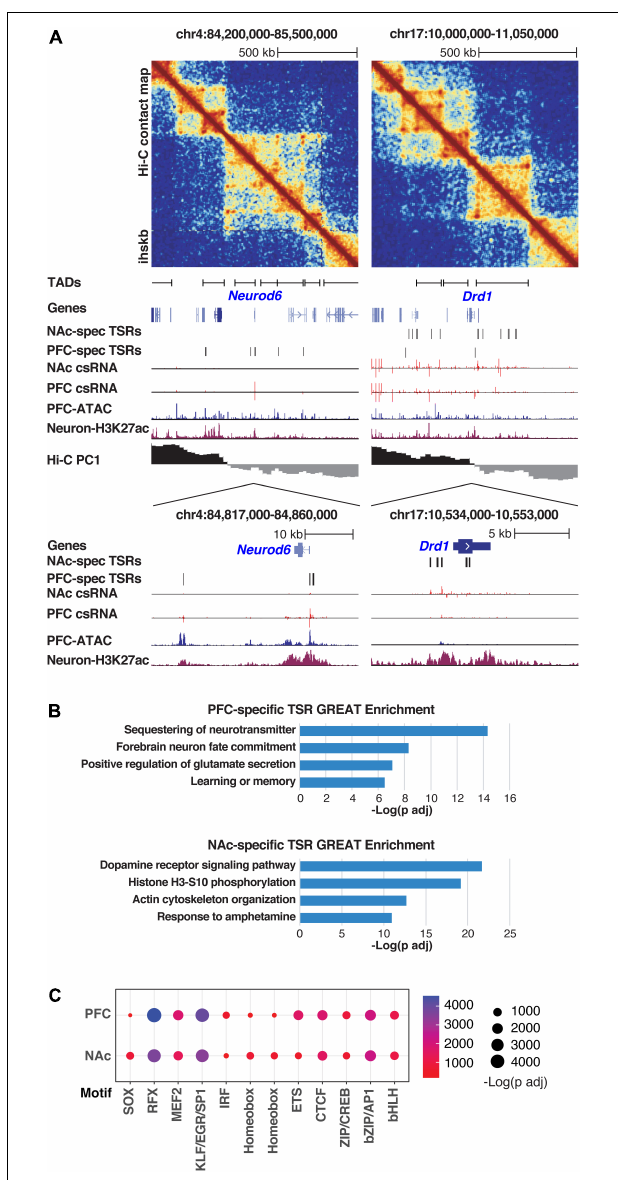
FIGURE 2 | Brain region specificity of Transcriptional Start Site Regions (TSRs). (A) Neurod6 (left) and Drd1 (right) gene loci are visualized, including (top to bottom) Hi-C contact matrix, TAD positions, genome browser tracks showing tissue-specific TSRs (csRNA-seq), chromatin accessibility (ATAC-seq), active histone mark (H3K27Ac), and A/B compartments (Hi-C PC1). Ihskb = interactions per hundred square kilobases per billion mapped reads. (B) Functional annotations associated with the genes near tissue-specific TSRs for PFC (top) and NAc (bottom) as determined by GREAT using mouse genome annotations (see methods). (C) Dotplot showing the enrichment scores of known TF motifs in TSRs from PFC and NAc. Size and color of the dots represent the -log adjusted p- value as determined by